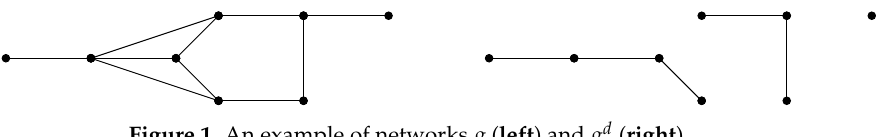
Figure 1. An example of networks g ( left ) and g d ( right